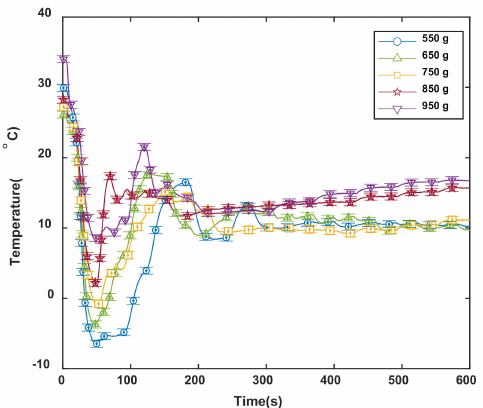
Figure 7. Variation in evaporation temperature over time with refrigerant charge amount.